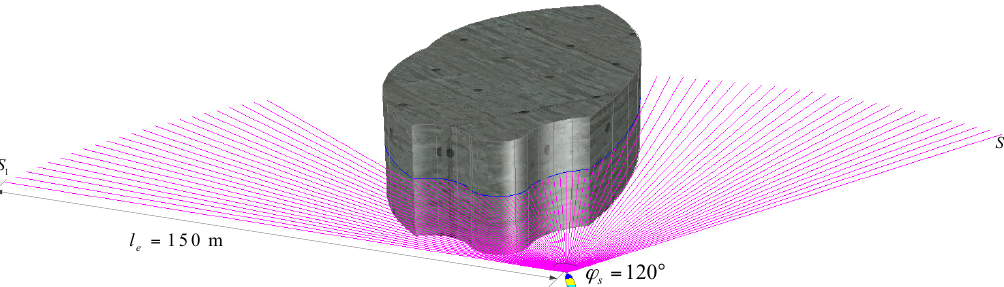
Figure 2. Obstacle detection diagram.